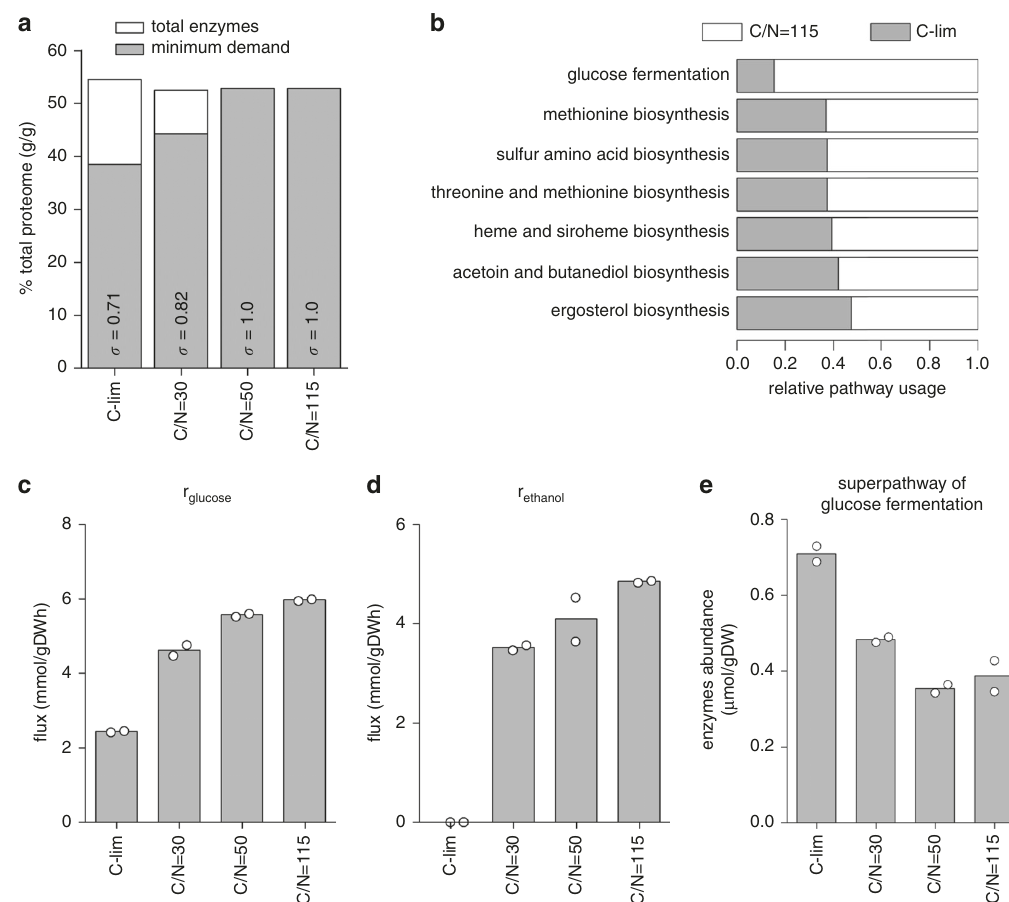
Fig. 3 Metabolic superpathways maintain large reserve capacities in carbon-limited cultures. a Total enzyme abundance is compared with the minimum enzyme demand calculated in silico by ecYeast8.1 for each condition. The enzyme saturation coef fi cient σ is shown (see Methods). b Enzyme usage for selected yeast metabolic superpathways. Flux balance analysis (FBA) with random sampling was implemented in ecYeast8.1 to estimate the optimal enzyme requirement for each enzyme (see Methods). Pathway usage was computed as the sum of simulated enzyme requirement divided by the sum of measured enzyme abundance in the pathway. Pathways with relative usage <50% between C-limited and C/N = 115 cultures are shown. c Glucose consumption rate ( r glucose ) was measured under different culture conditions. Bars are mean of biological duplicates. d Ethanol production rate ( r ethanol ) was measured under different culture conditions. Bars are mean of biological duplicates. e Absolute abundance of enzymes in the superpathway of glucose fermentation was calculated. Bars are mean of biological